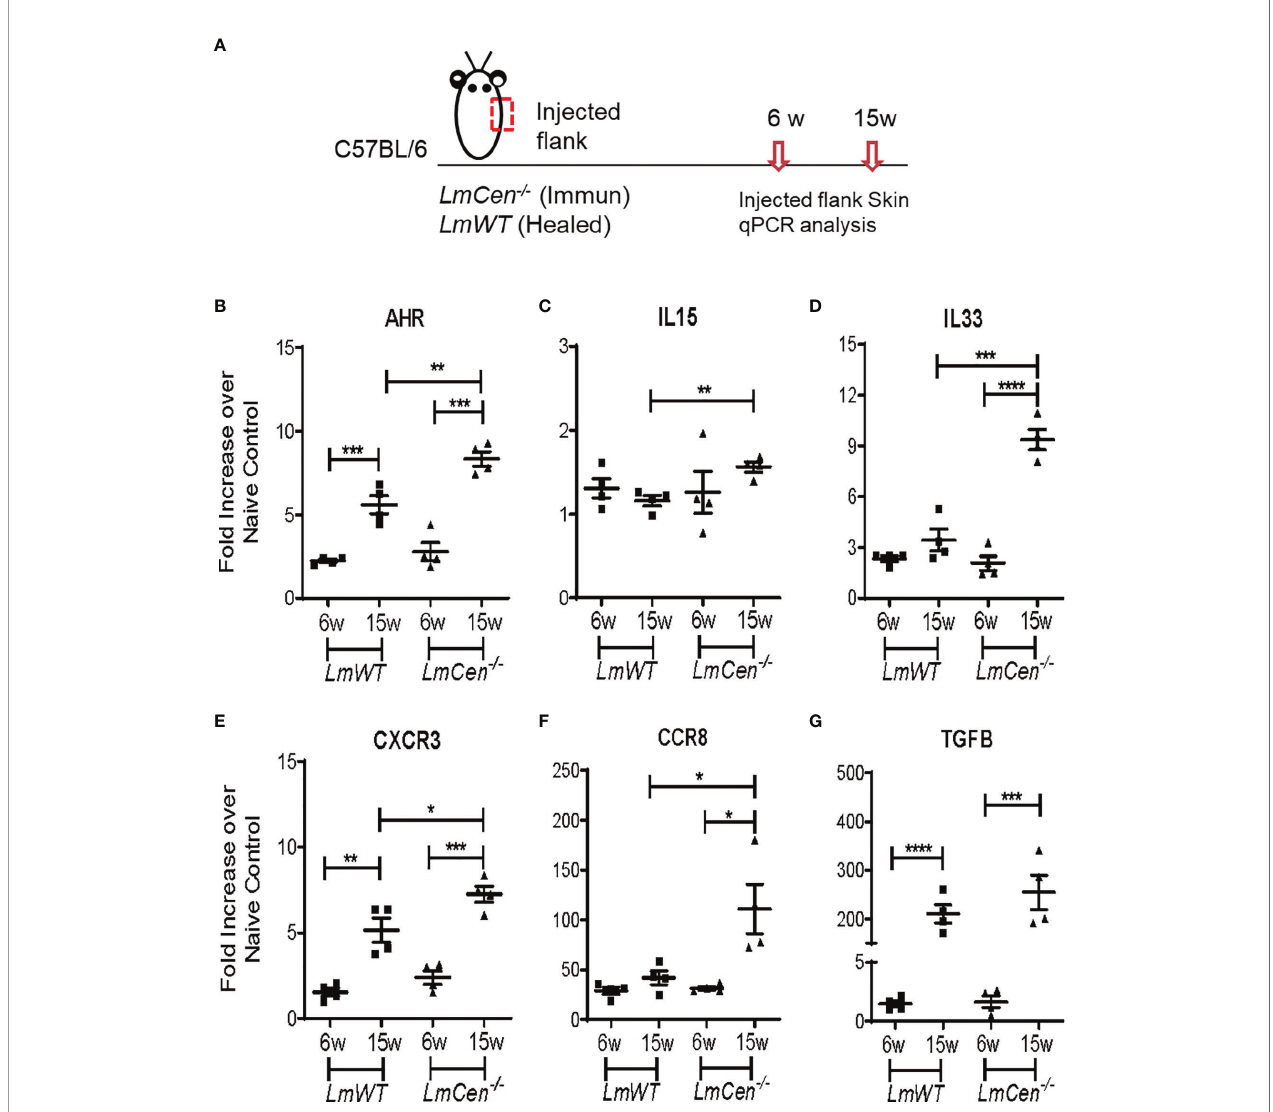
FIGURE 2 | Expression pro fi le of cytokines and chemokine receptors supporting TRM cell generation at the injected fl ank skin. Mice were injected with LmCen -/- or LmWT , intradermally, in the right fl ank. The expression pro fi le of indicated genes from the injected fl ank skin was assessed at 6 and 15 weeks (6w and 15w) post- injection by qPCR. (A) Schematic plan of the experimental time points and injection site. (B – G) Expression of different transcripts, (B) AHR , (C) IL15, (D) IL33 , (E) CXCR3, (F) CCR8, and (G) TGFB, at indicated time points. To determine the fold expression of each gene, 2 - DD CT method was employed. The data were normalized to GAPDH expression and shown as the fold change relative to age-matched naive mice. Results are representative of one of two independent experiments, with total 4 mice per group. Bars represent the means with SEM in each group. Statistical analysis was performed by unpaired two-tailed t test (* p <0.05, ** p < 0.009, *** p <